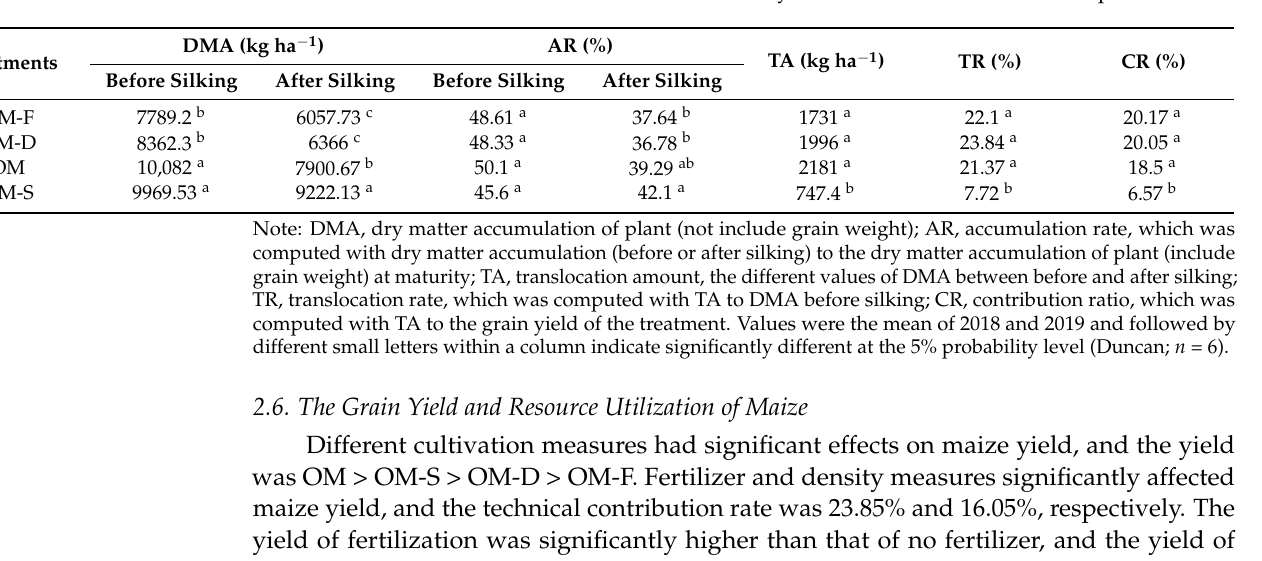
Table 2. Effect of different cultivation measures on dry matter accumulation and transport of